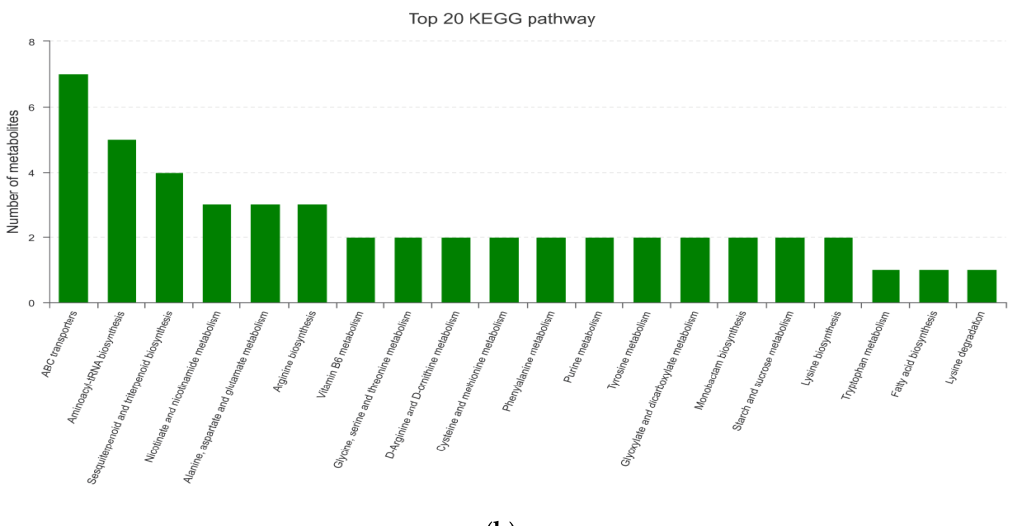
Figure 3. Path analysis and functional annotation based on KEGG (( a ) path analysis; ( b ) functional annotation).